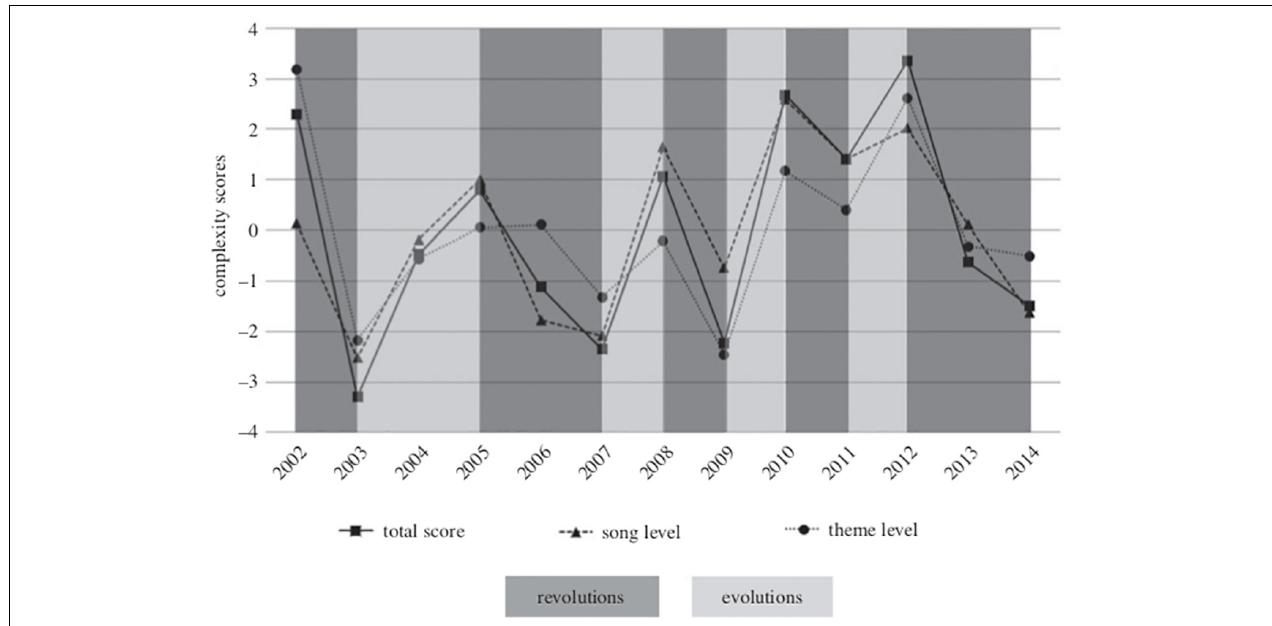
FIGURE 3 | Taken from Allen et al. (2018): “Song complexity scores for each year (2002–2014) representing complexity at the (i) song-level, (ii) theme-level, and (iii) total complexity. Revolution and evolution transitions are demarcated”.